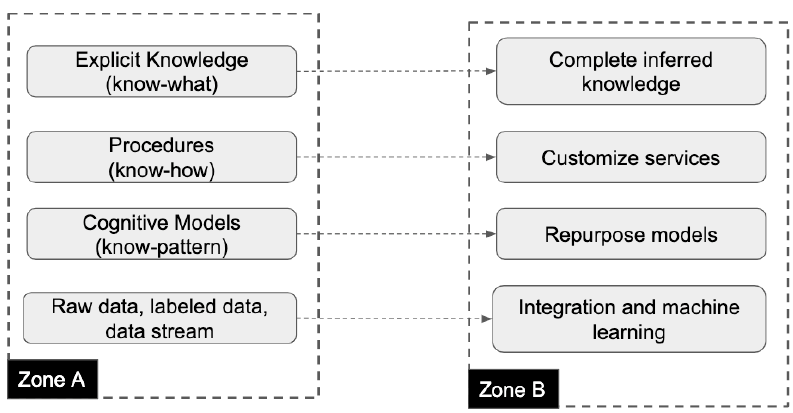
Figure 3. Zone communication